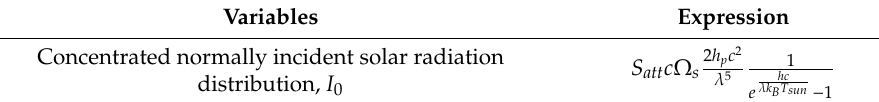
Table 2. Variables used in the computational